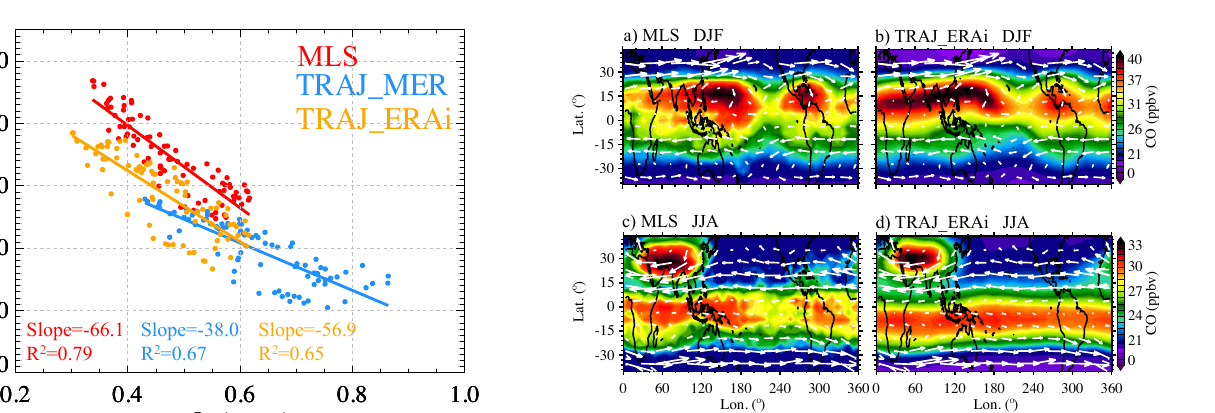
Figure 11. Comparison of CO at 68hPa ( ∼ 20km) during DJF (top row, a and b ) and JJA (bottom row, c and d ) between MLS (left) and trajectory modeling driven by ERAi wind (right, weighted by the MLS averaging kernels). Horizontal wind vectors from ERAi are overlaid as